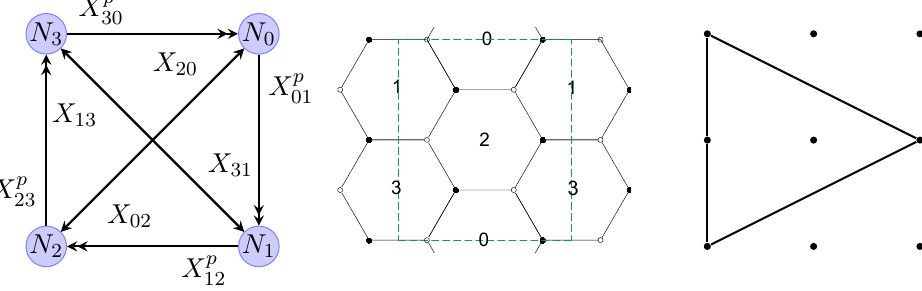
Figure 24. The quiver (left), the dimer (center) and the toric diagram (right) of C 3 = Z 4